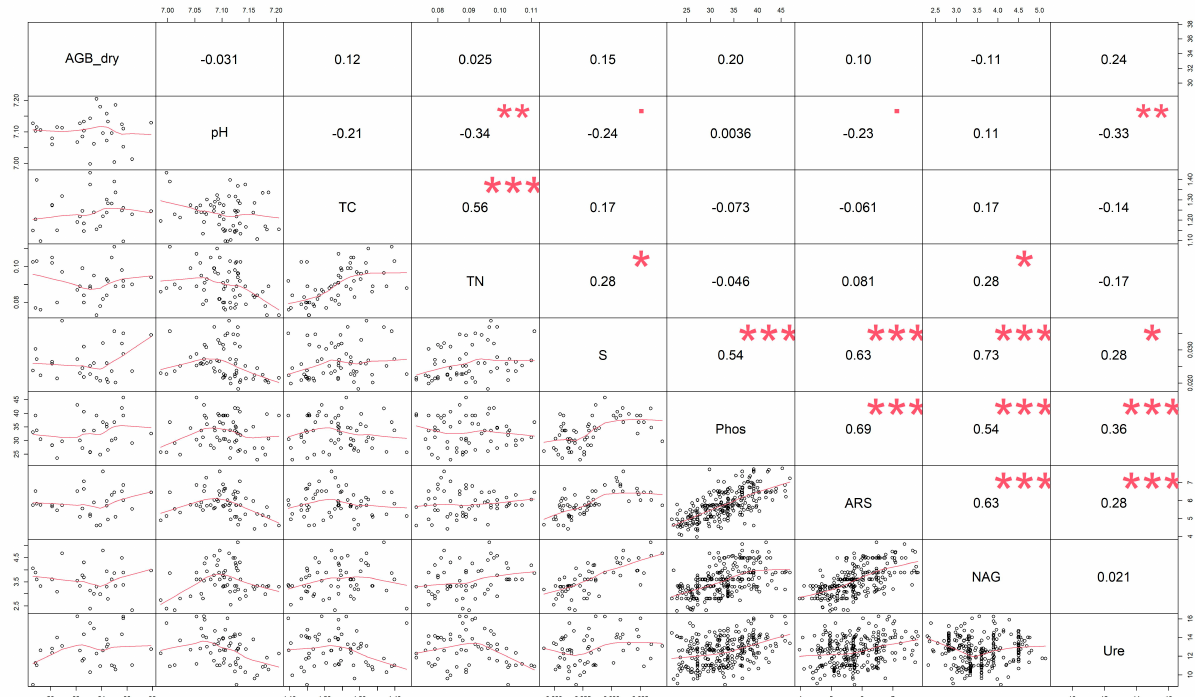
Figure A1. Results of Pearson’s correlation analysis in the pre-cultivation of maize in the pot exper- iment. The symbols indicate differences between the variables at the following levels of statistical